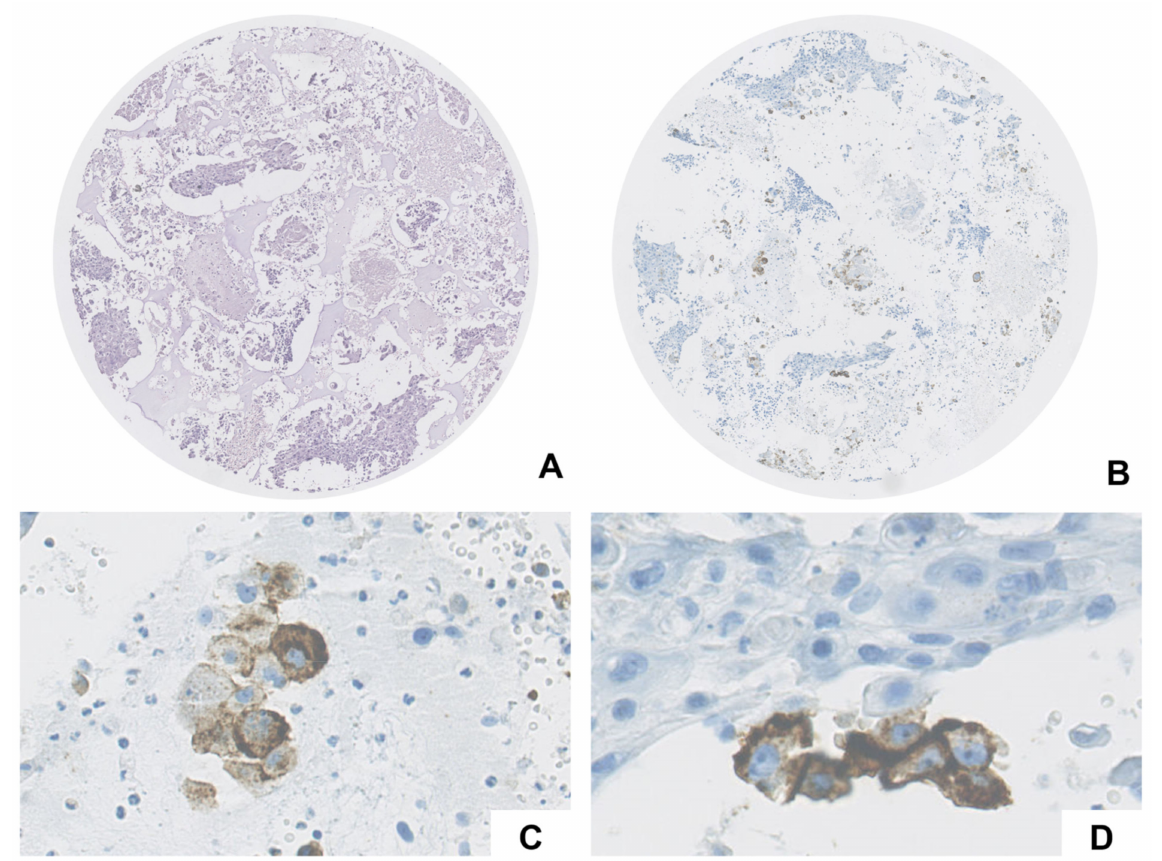
Figure 2. Case ID 25: metastasis from squamous cell carcinoma ( A , B ) showed positivity in both immune (cytoplasmic granular staining in macrophages, ( C )) and neoplastic cells (complete linear membrane staining, ( D )). Table 1. Sample